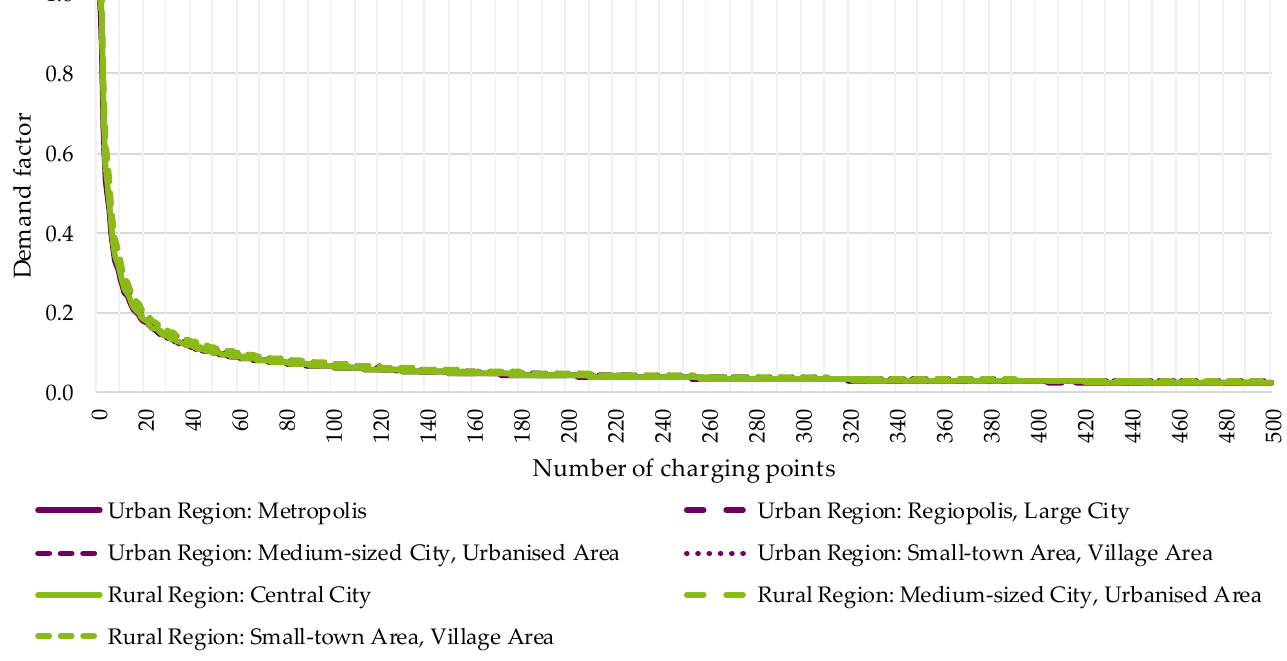
Figure 19. Demand factors (ordinate) for 150 kW charging power and seven different area types.